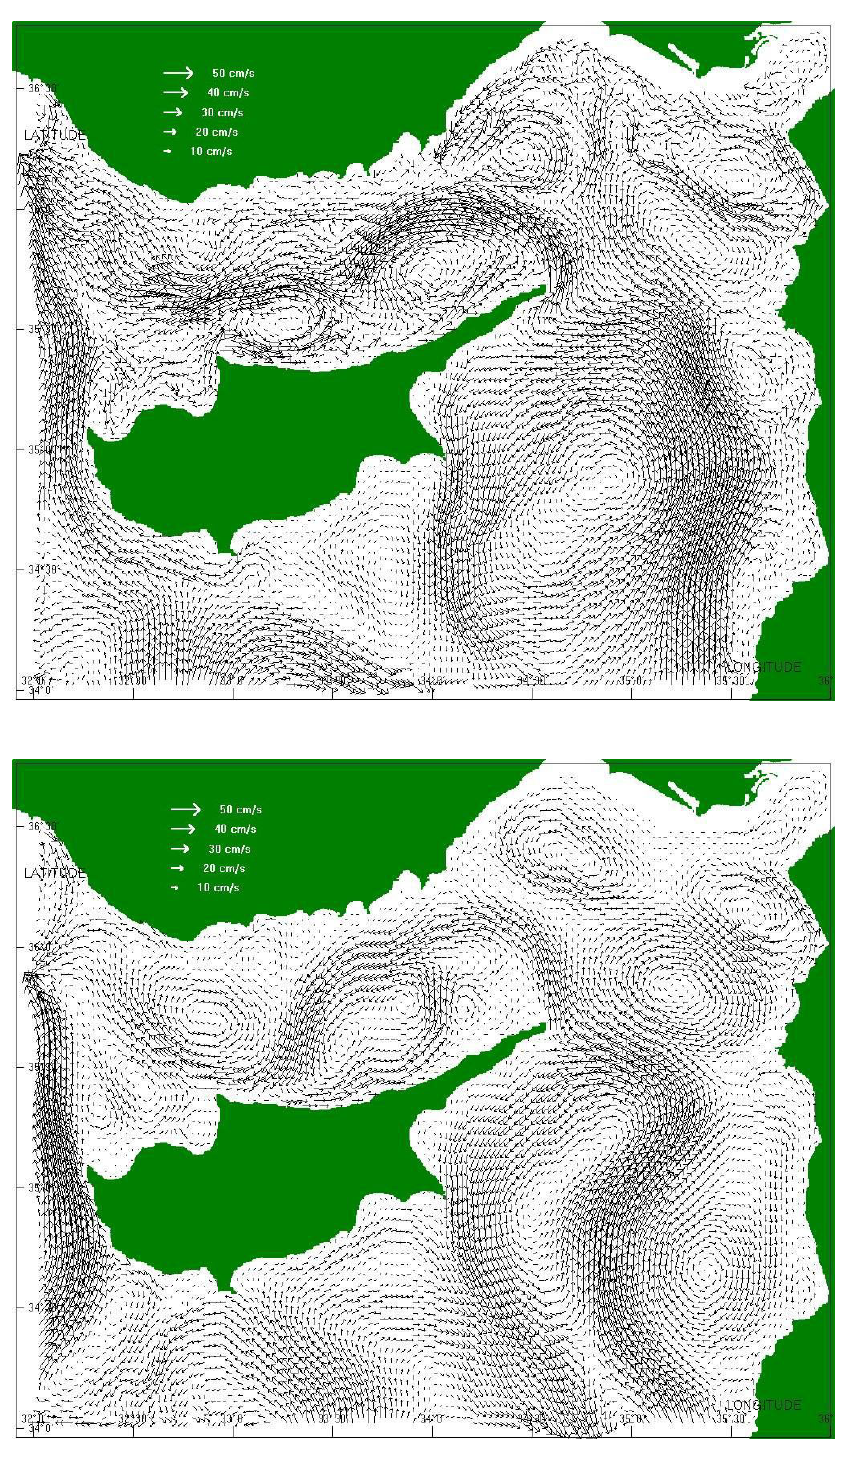
for April of the second year of the cli- matological